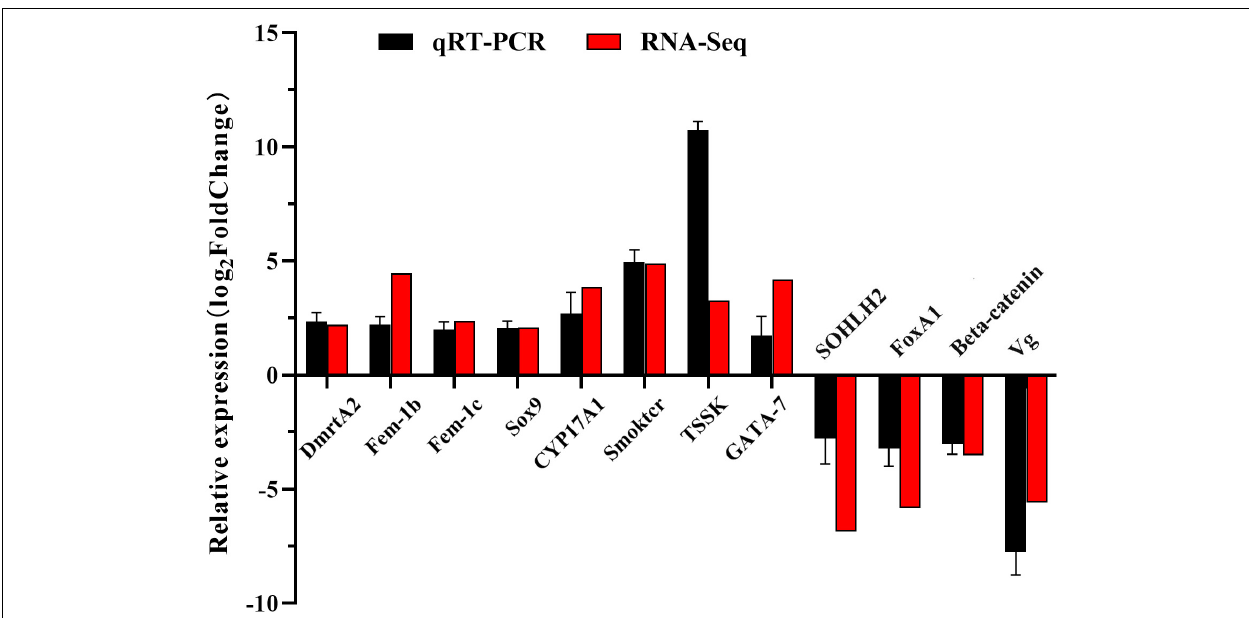
FIGURE 7 | qRT-PCR and RNA-seq validation results. Expression comparisons of 12 sex-biased gene in female and male gonads in S. constricta . The Y -axis represented log 2 FoldChange determined by qRT-PCR and RNA-seq. The mean values and error bars were obtained from three biological and three technical replicates for qRT-PCR results.